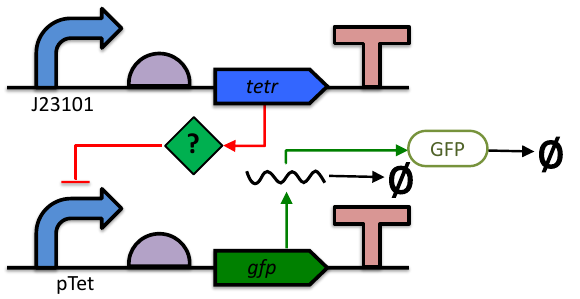
Figure 39: Constitutive production of TetR, except that information about the protein is missing, leaving it as the default unspecified glyph. TetR represses the pTet promoter, which is regulating production of GFP. The diagram of GFP production explicitly includes the intermediate mRNA and the degradation of both the mRNA and protein products.